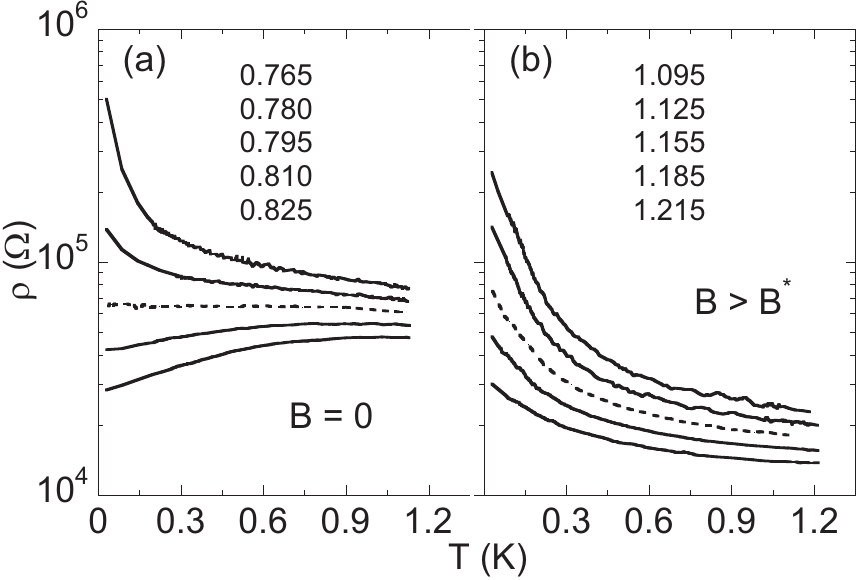
Figure 3. Temperature dependence of the resistivity of a Si MOSFET at different electron densities near the MIT in zero magnetic field ( a ) and in a parallel magnetic field of 4 Tesla ( b ). The electron densities are indicated in units of 10 11 cm − 2 . Dashed curves correspond to n s = n ∗ c , which is equal to 0.795 × 10 11 cm − 2 in zero field and to 1.155 × 10 11 cm − 2 in B = 4 Tesla. Adapted from